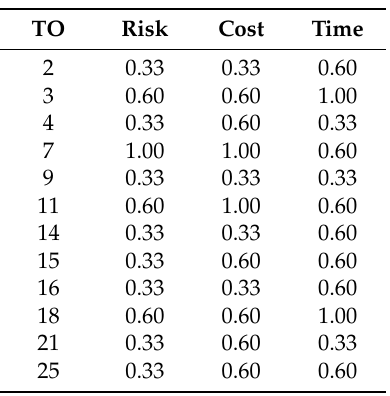
Table 5. Normalized matrix.